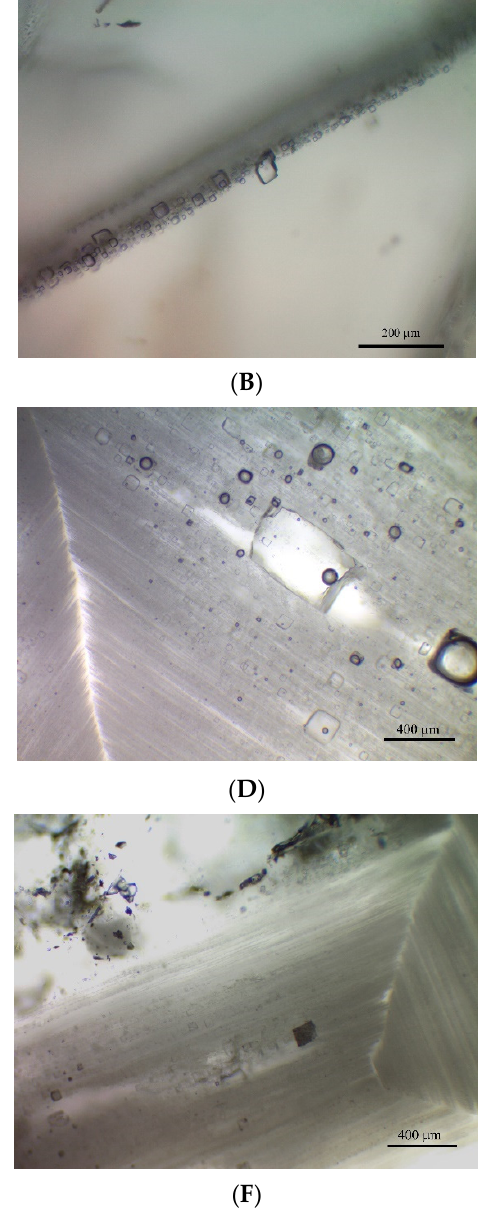
Figure 3. Sedimentation textures of halite. ( A , B ) Relics of surface (cumulate) halite: Solotvyno, Mine No. 9, Sample 34; ( С – F ) bottom-growth (chevron) halite: Mukachevo, Borehole 6-T ( C , D ); Sl ă nic-Prahova, Sample P-25 ( E , F ).